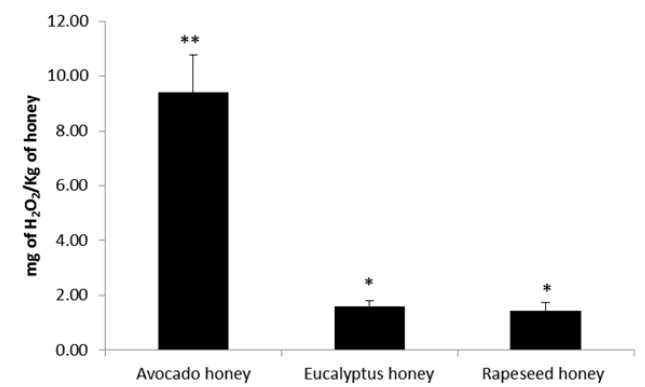
Figure 2. H 2 O 2 values of the three monofloral honeys studied. Columns belonging to the same set of data with different symbols are significantly different. * p < 0.05 and ** p < 0.01 .